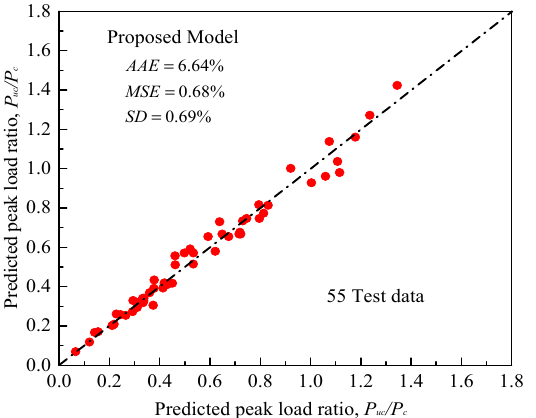
Figure 7. Comparison between experimental and predicted peak load ratios for columns with internal steel confinement.